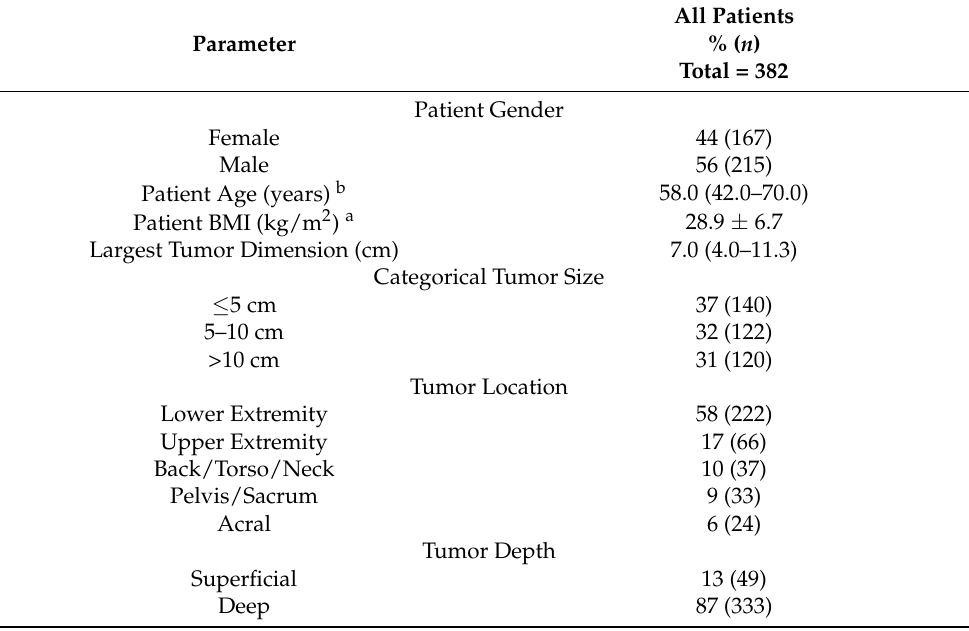
Table 2. Patient, tumor, and treatment